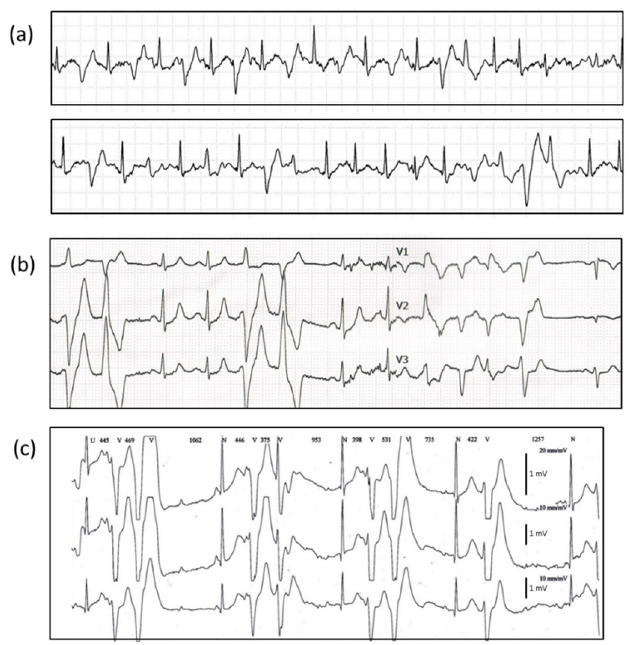
Figure 2. Abnormal ECGs during ESTs in D3291V heterozygous carriers. ( a ) EST performed in an asymptomatic untreated subject (III.14, family 1) after genetic diagnosis at the age of 17 showing bigeminy, bi-directional doublets, and ventricular tachycardia at 125 W; ( b ) Polymorphic ventricular tachycardia during EST in a 44-year-old subject treated with 80 mg of nadolol (III.2, family 1). Her daughter (IV.3) was also treated with 80mg of nadolol and developed PVT; ( c ) Holter recording of an untreated child (IV.13, family 1) at the age of 2 with AVB and bi-directional ventricular doublets at 110 bpm.